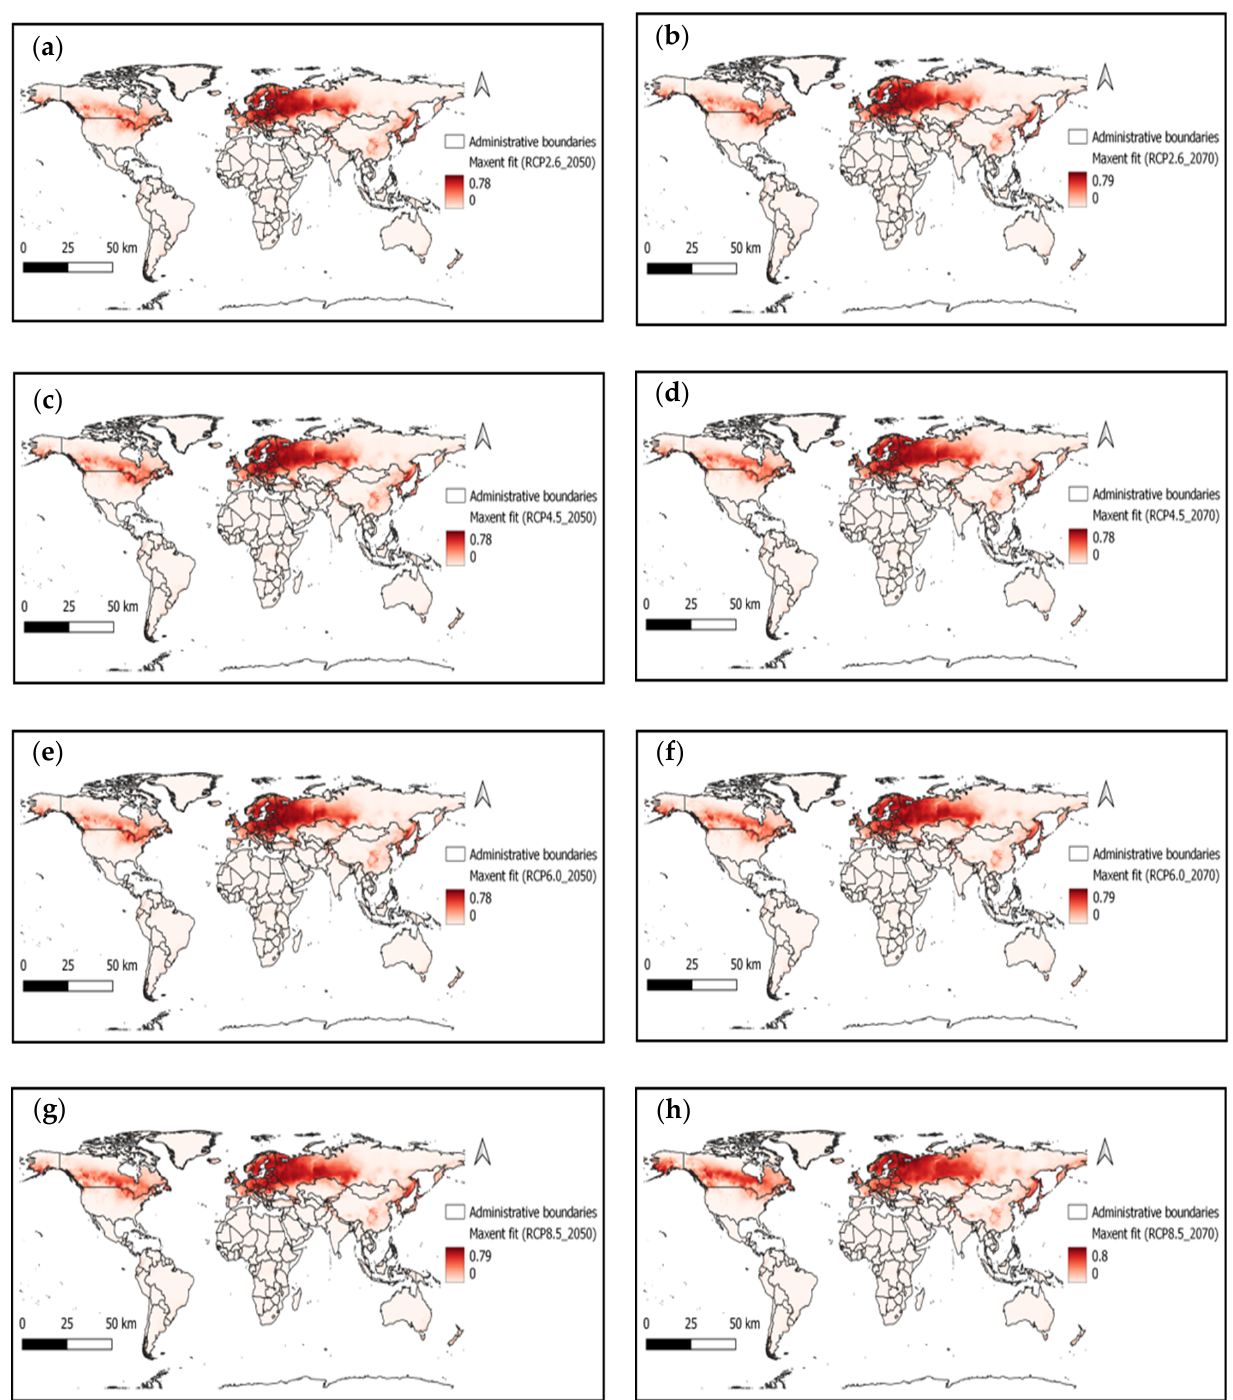
Figure 3. ASFV suitability map with different ( a ) RCP 2.6_2050, ( b ) RCP 2.6_2070, ( c ) RCP 4.5_ 2050, ( d ) RCP 4.5_ 2070, ( e ) RCP 6.0 _ 2050, ( f ) RCP 6.0 _2070, ( g ) RCP 8.5_ 2050, and ( h ) RCP 8.5_ 2070 scenarios.